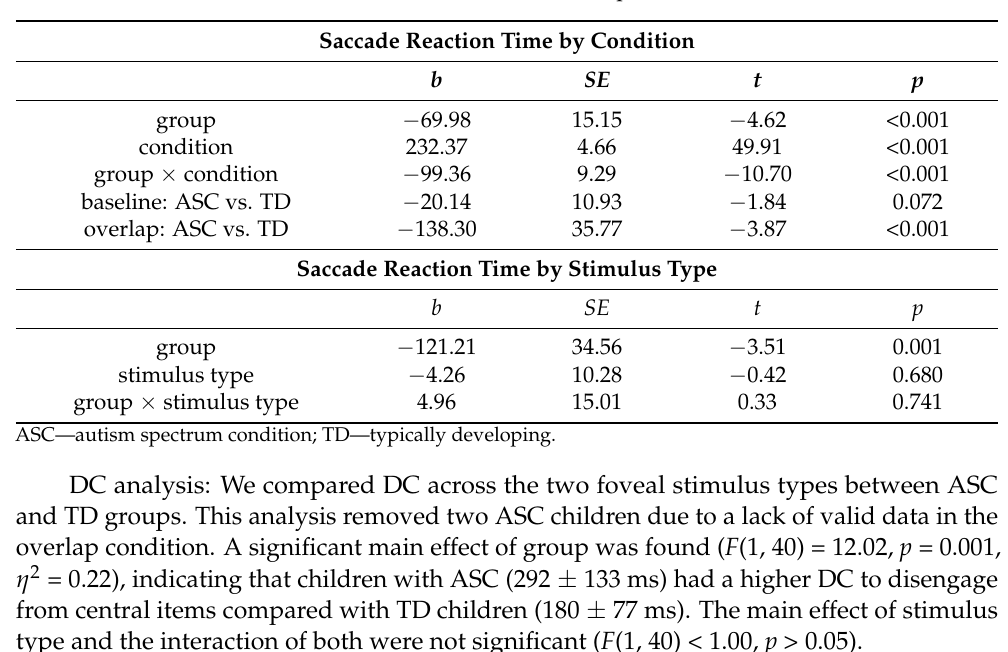
Table 7. Fixed effect estimates on saccade reaction time in Experiment